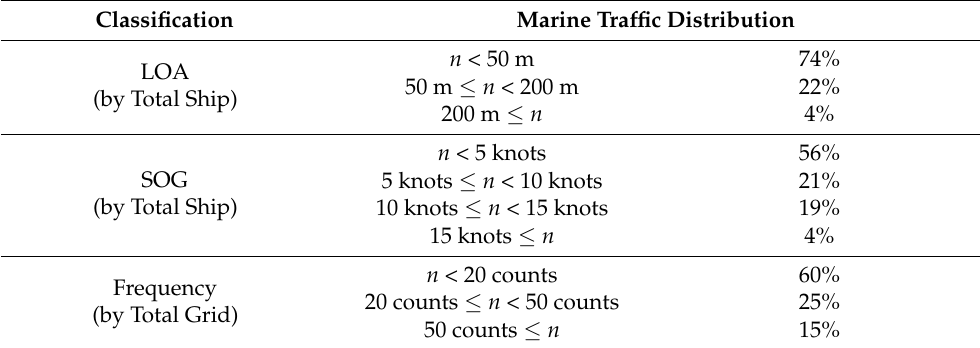
Table 10. Distribution analysis of vessel traffic in Korean coastal waters using AIS data. Classification Marine Traffic Distribution n < 50 LOA (by Total Ship)